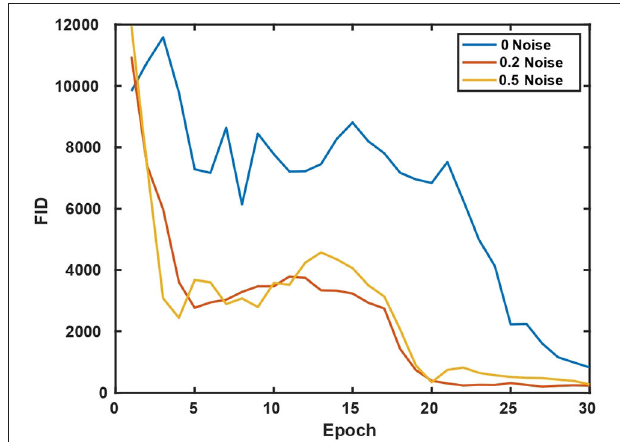
FIGURE 6 | Frechet Inception Distance w.r.t various standard deviations of noise.